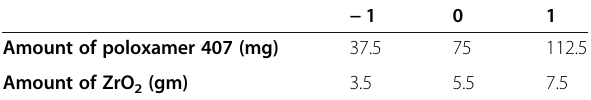
Table 1 Design of experiments: factors and levels for 3 2 full